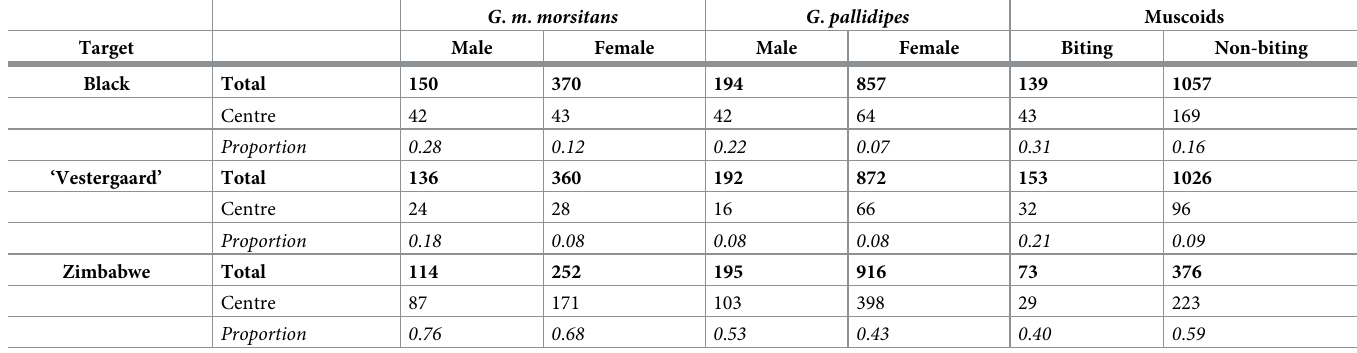
Table 2. Total numbers of flies caught over 87 sampling days of experiment 1, the number caught on the centre target panel, and that number expressed as a pro- portion of the total. G . m . morsitans G . pallidipes